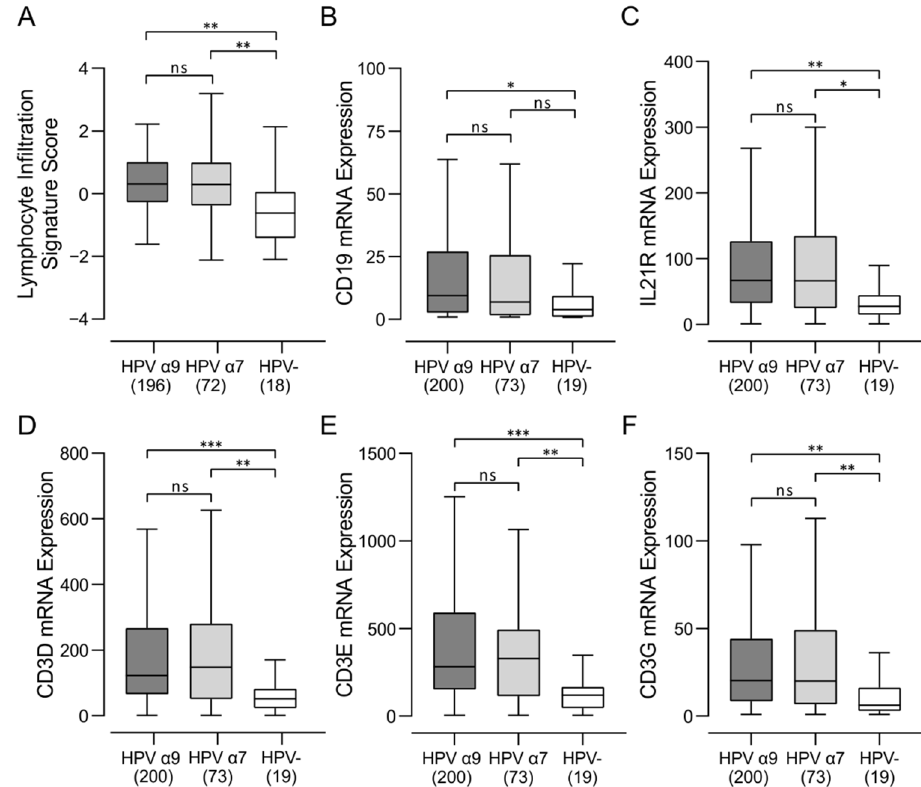
Figure 1. Analysis of tumor infiltrating lymphocytes and subsets in HPV-positive (HPV α 9 and HPV α 7) and HPV-negative (HPV-) cervical cancer. ( A ) Comparison of Lymphocyte Infiltration Signature Score between HPV α 9, HPV α 7, and HPV-negative cervical cancers. Values were extracted from Thorsson et al. [26] and HPV status annotated manually; ( B – F ) expression of marker genes related to B-cell (CD19, IL21R) and T-cell (CD3D, CD3E, CD3G) infiltration. Numbers in brackets refer to the number of samples included in each analysis. *** p ≤ 0.001, ** p ≤ 0.01, * p ≤ 0.05, ns (not significant).